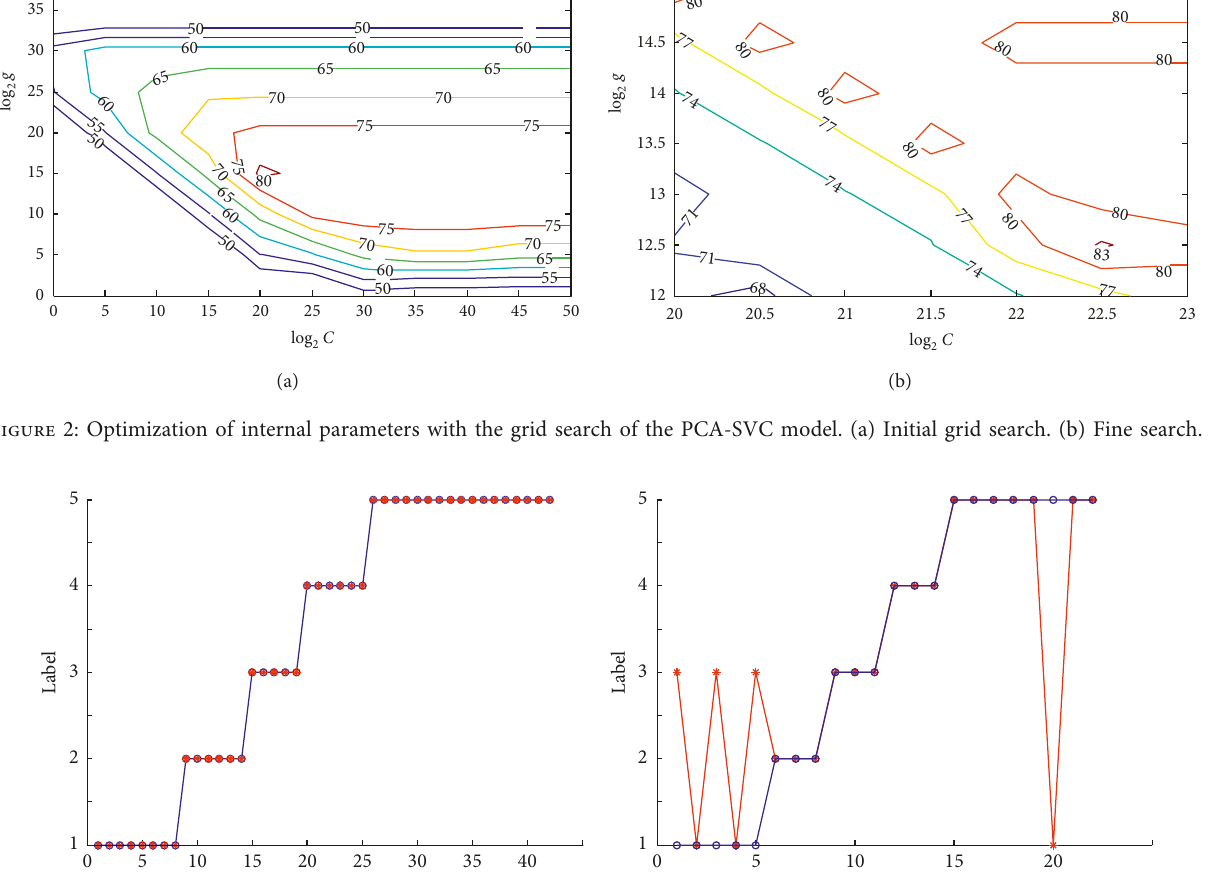
Figure 4. The regression equation of the PLSR-6 model